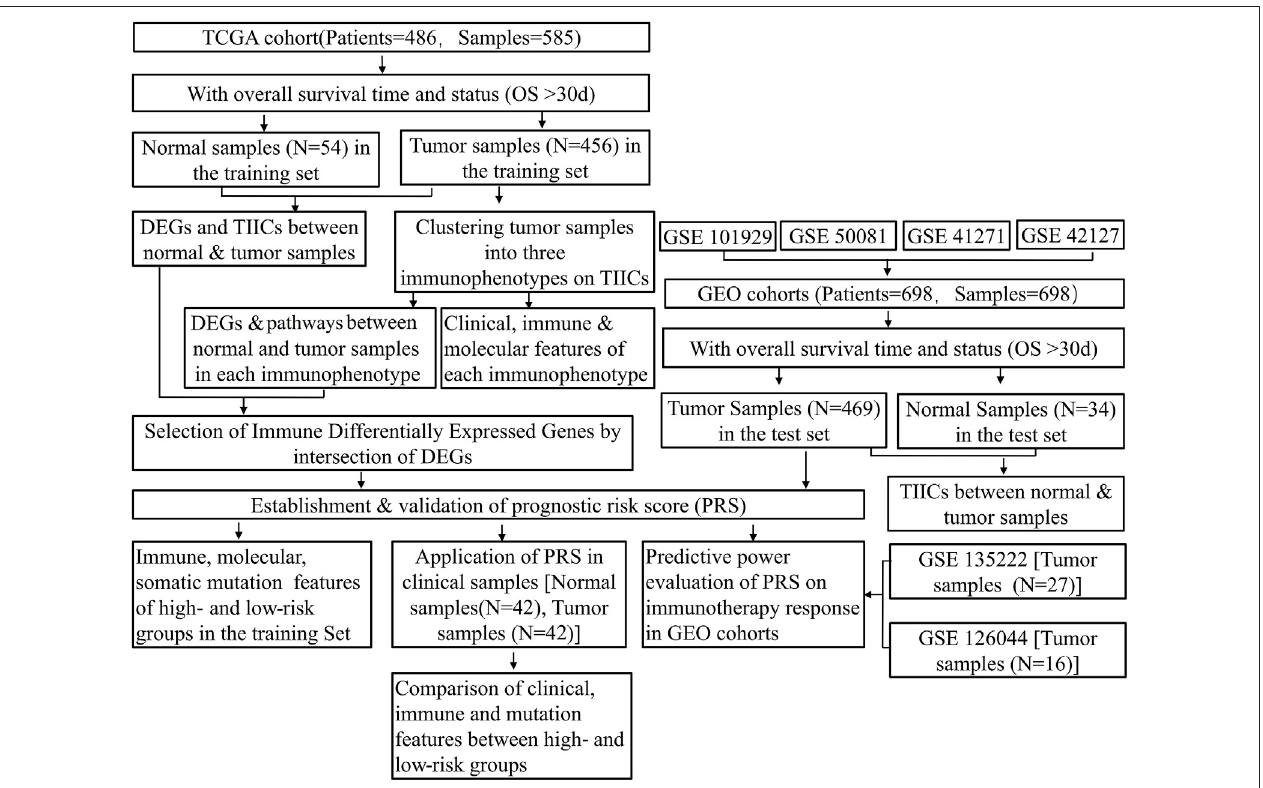
FIGURE 1 | Flowchart of the study protocol. TCGA, The Cancer Genome Atlas; GEO, Gene Expression Omnibus; OS, overall survival; ESTIMATE, Estimation of STromal and Immune cells in MAlignant Tumor tissues using Expression data; TIICs, tumor-in fi ltrating immune cells; DEGs, differentially expressed genes; PRS, prognostic risk score.